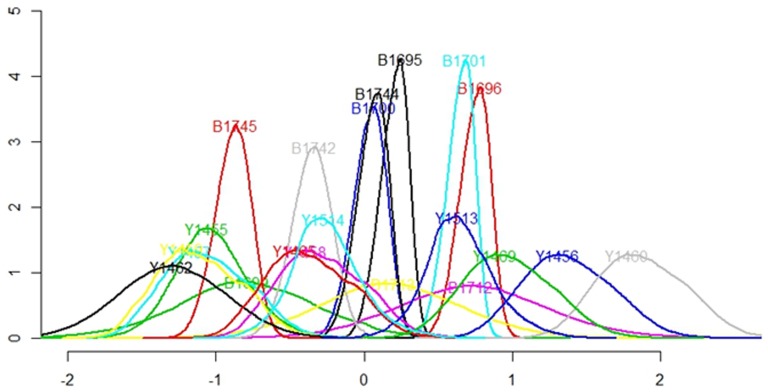
Density plot of the random effects in the model.A peak near −1 indicates that the individual performed more Type I bouts, a peak near +1 indicates more Type II bouts, and a peak near 0 indicates no distinct difference in the use of different bouts for that individual.